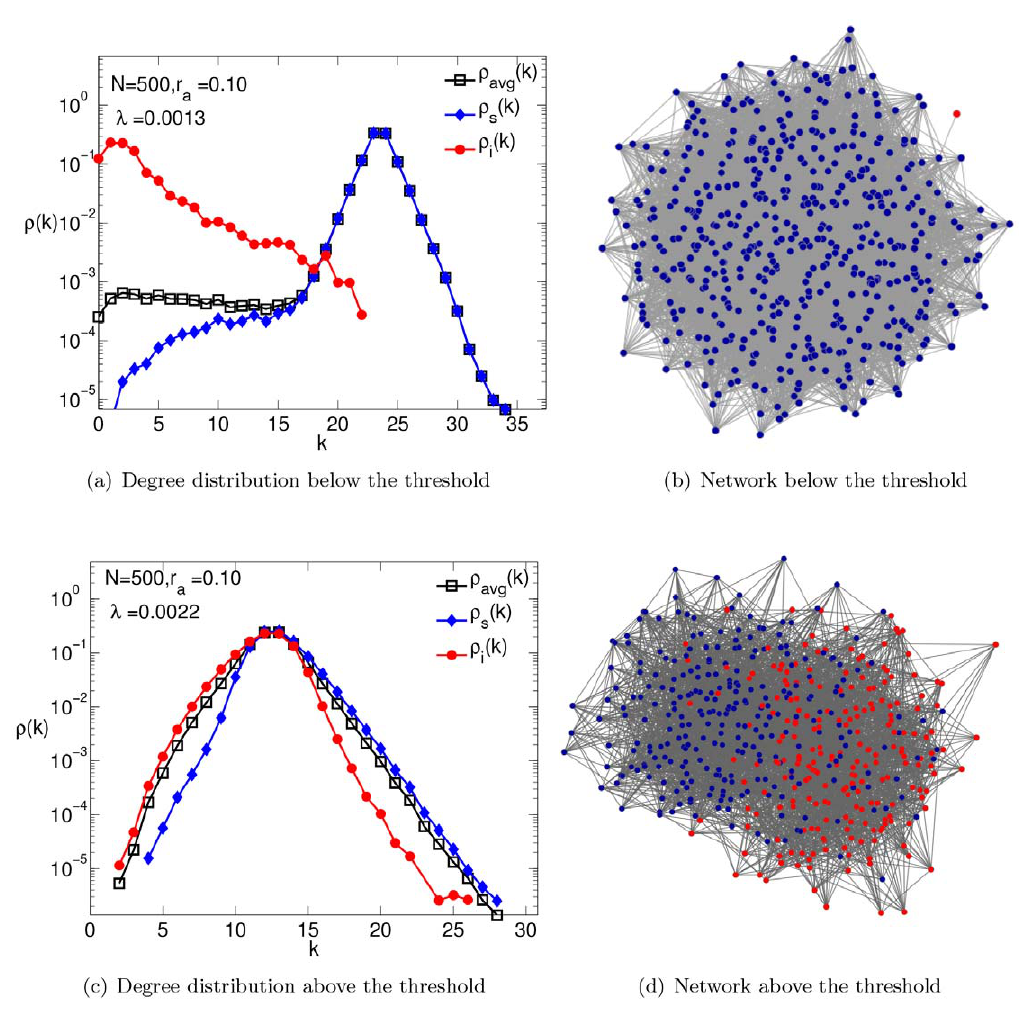
Figure 6. Degree distribution and network structures with typical local adaptations. Panels (a) and (b) show systems below the epidemic threshold, while (c) and (d) show systems above the threshold. The parameters chosen are N ~ 500, k 0 ~ 25, k min ~ 10, c ~ 10 k 0 , r a ~ 0 : 1 , l = m ~ 0 : 1 .